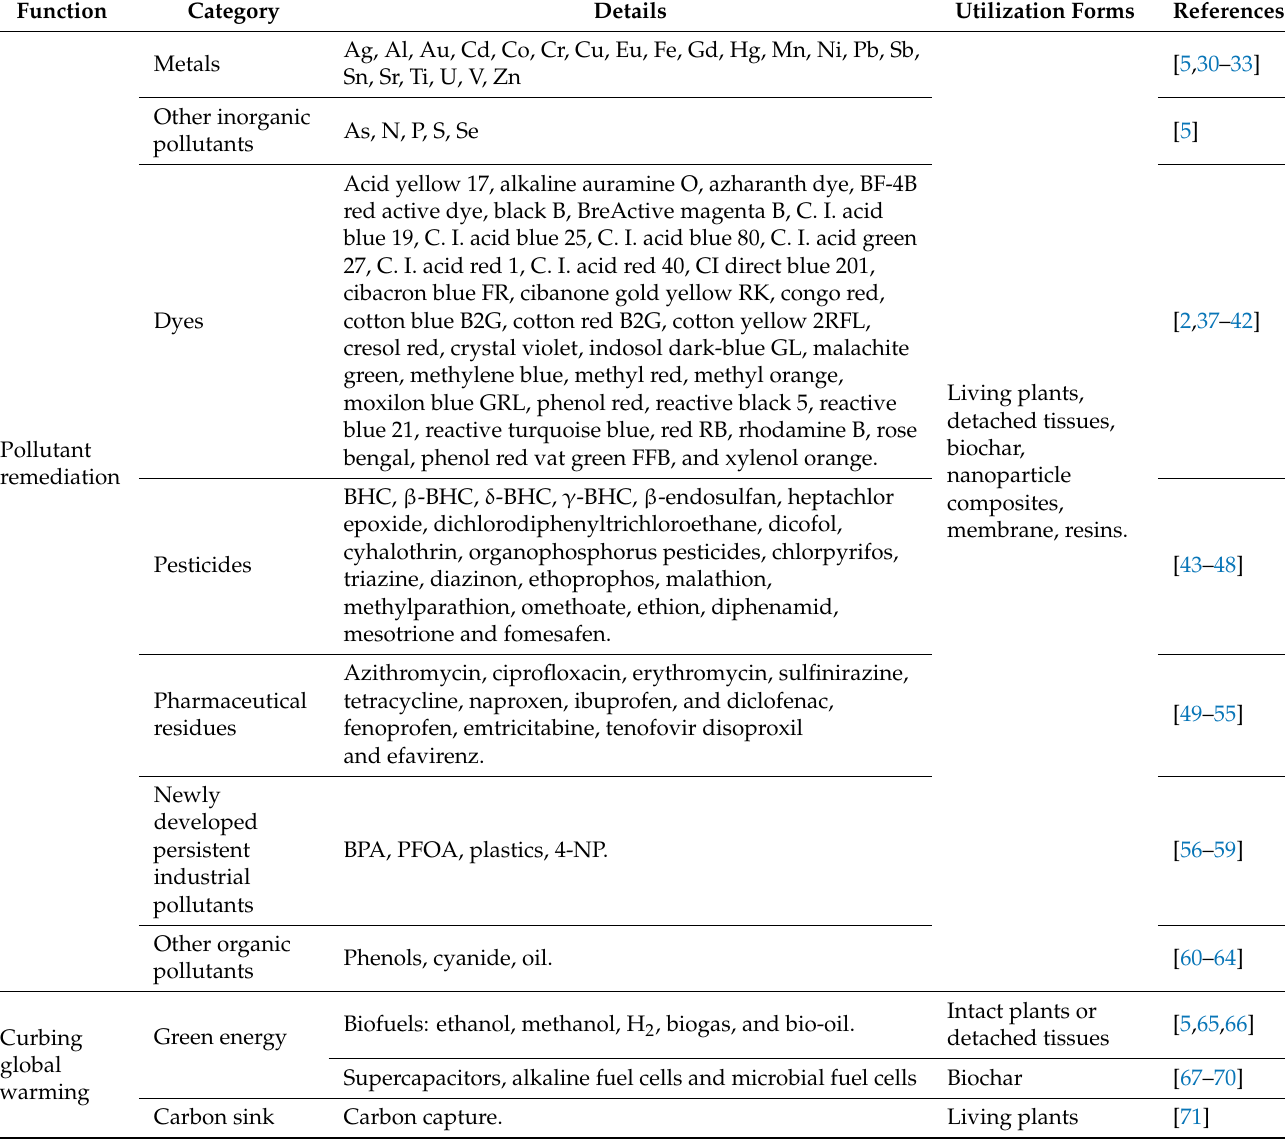
Table 1. Utilization of water hyacinth in maintaining environmental